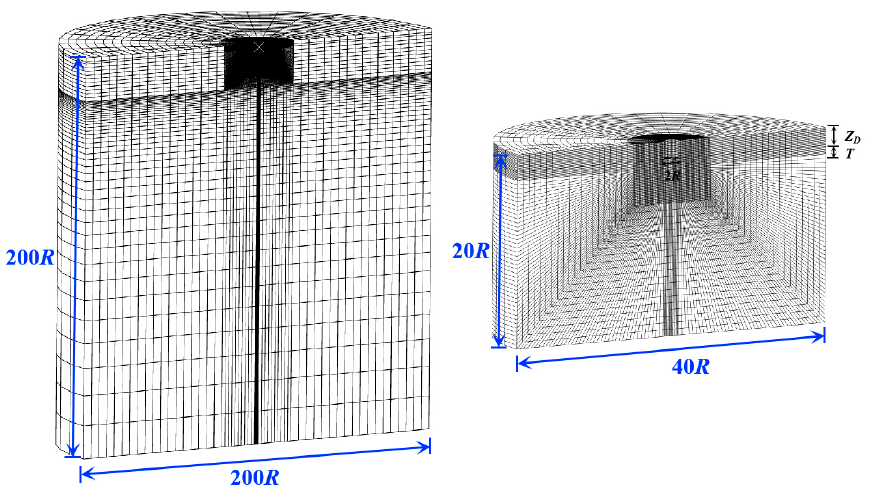
Figure 6. Typical FEM mesh employed in this study.